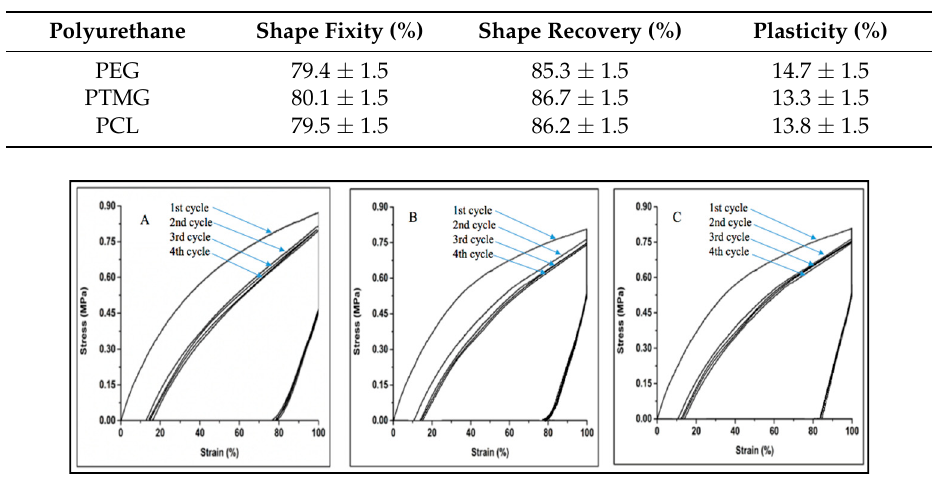
Table 3. The shape memory properties of the different polyurethanes.